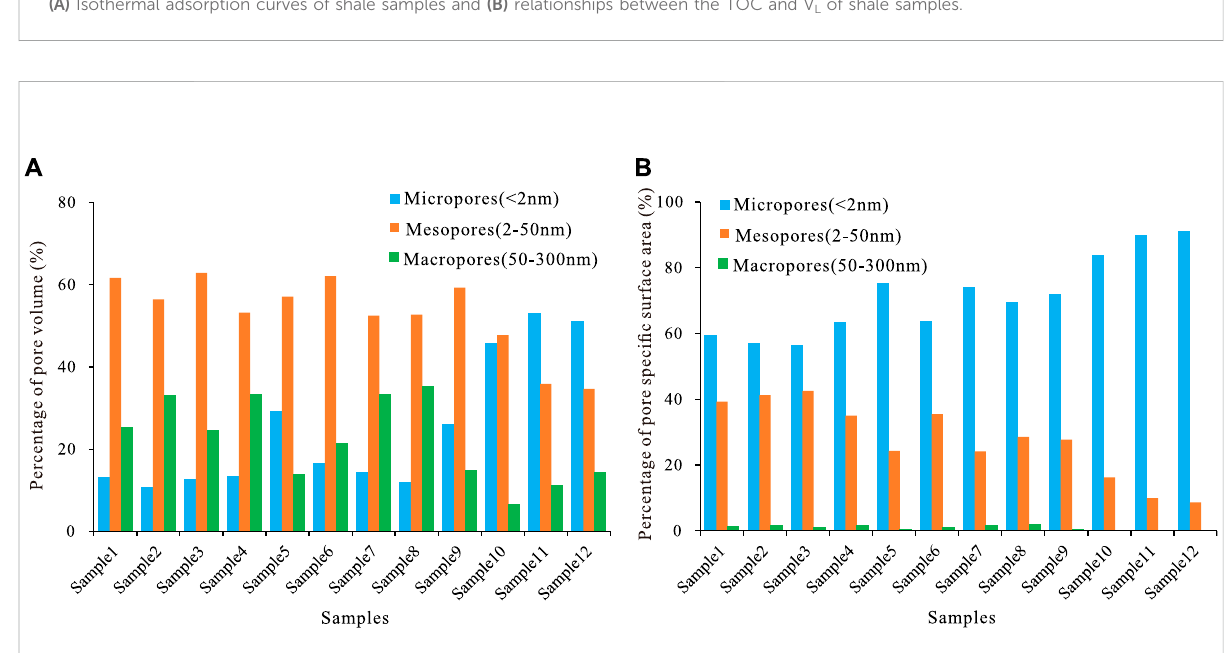
FIGURE 9 Distributions of different scales of pores acquired from LT-N 2 GA and LP-CO 2 GA [ (A) percentage of the PV; (B) percentage of the pore SSA].